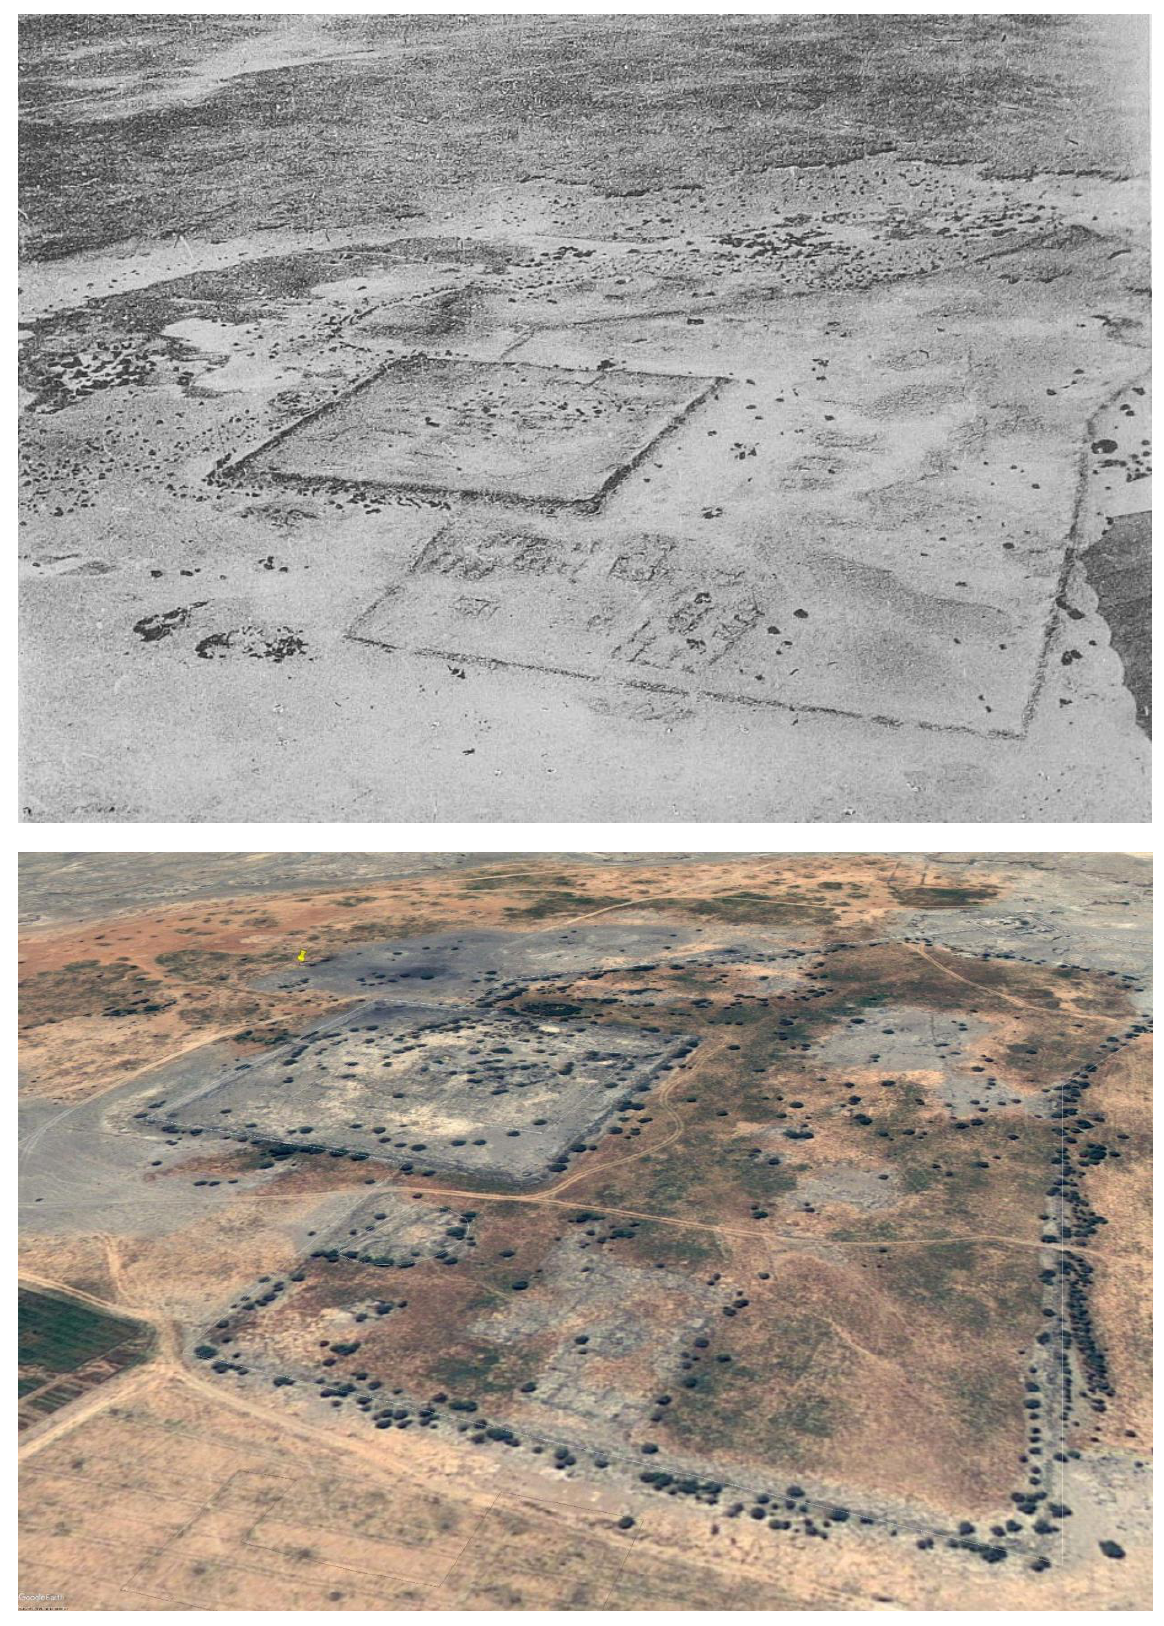
Figure 15: Ar-Rafi'ah / Bir Kesab Photo by A.Poidebard 1932 and a current satellite image in direct comparison. Note the possible theatre in the middle-left section of the Image. Oblique view/aerial view from the north-west. (Google; Digital Globe